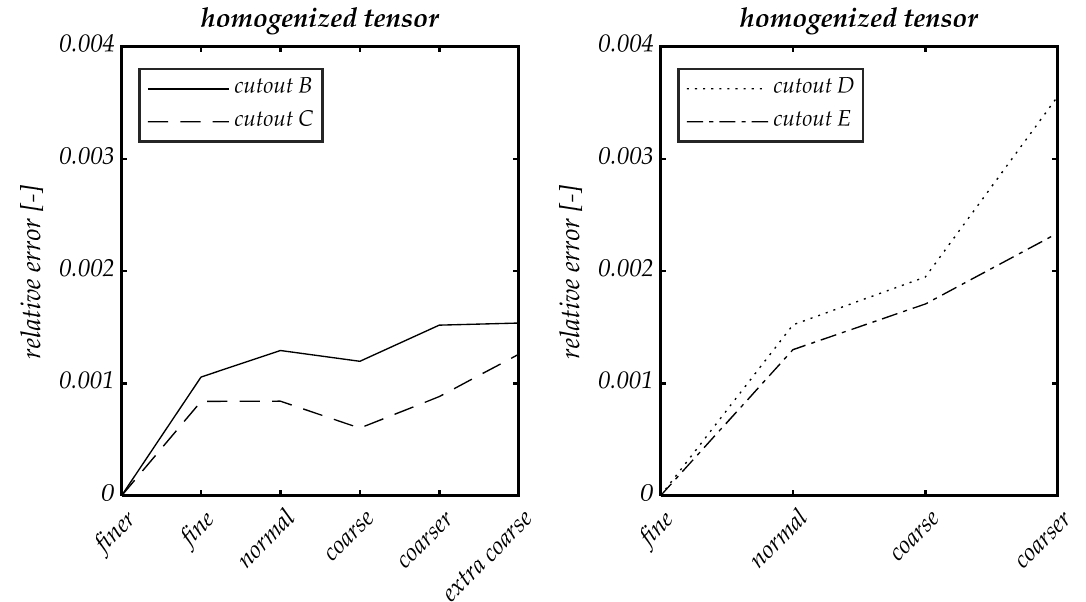
Figure 6. Relative errors of the homogenized tensors for the different element sizes in cut-outs B, C, D and E shown in Figure 5.